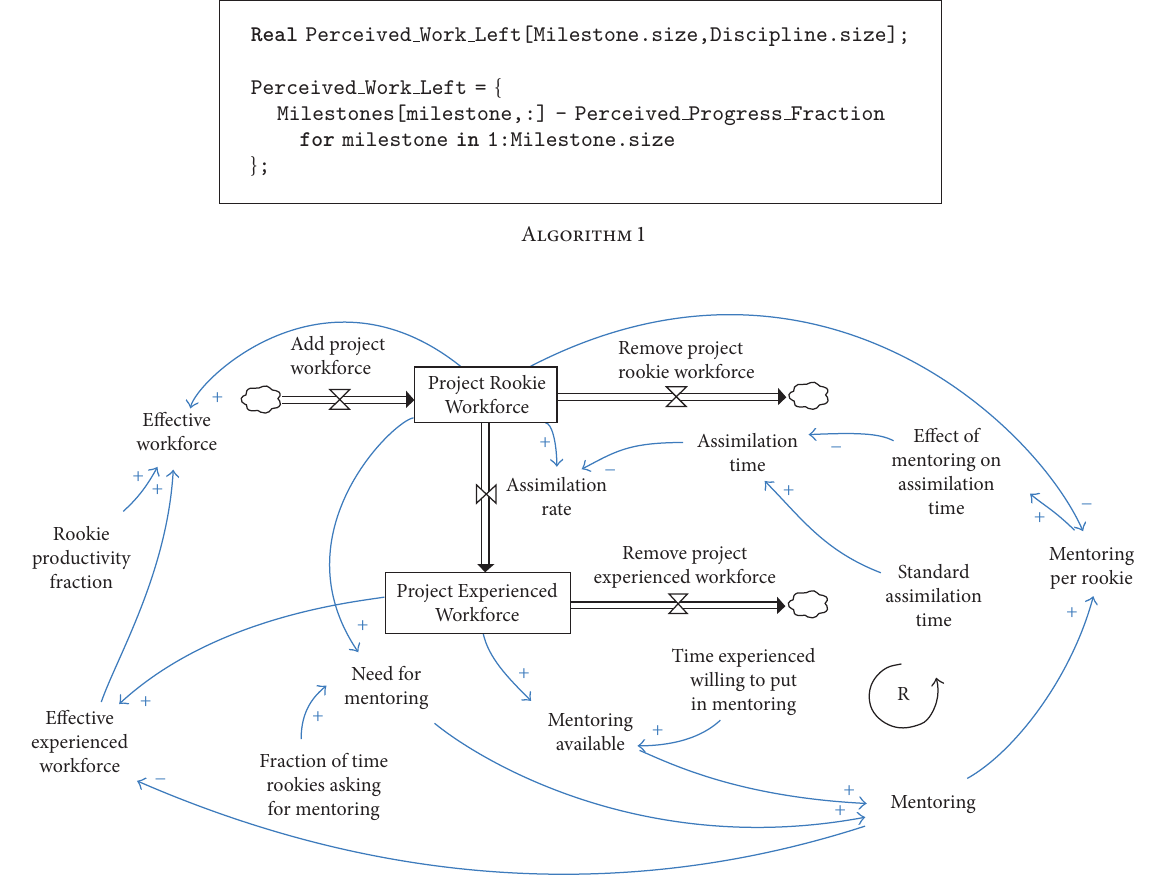
Figure 5: Project experience